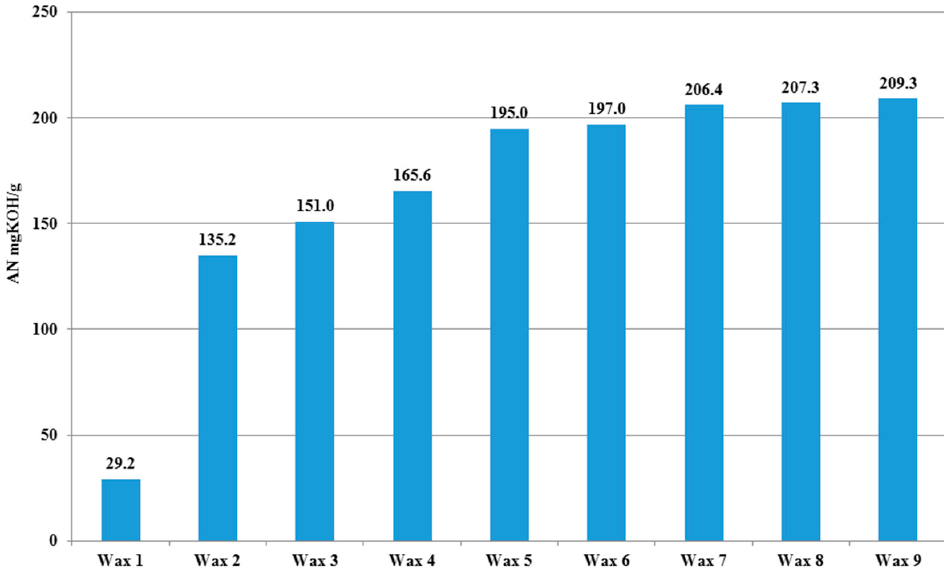
Figure 1. Acid number (AN) of O-PEW obtained in the melt phase oxidation process.